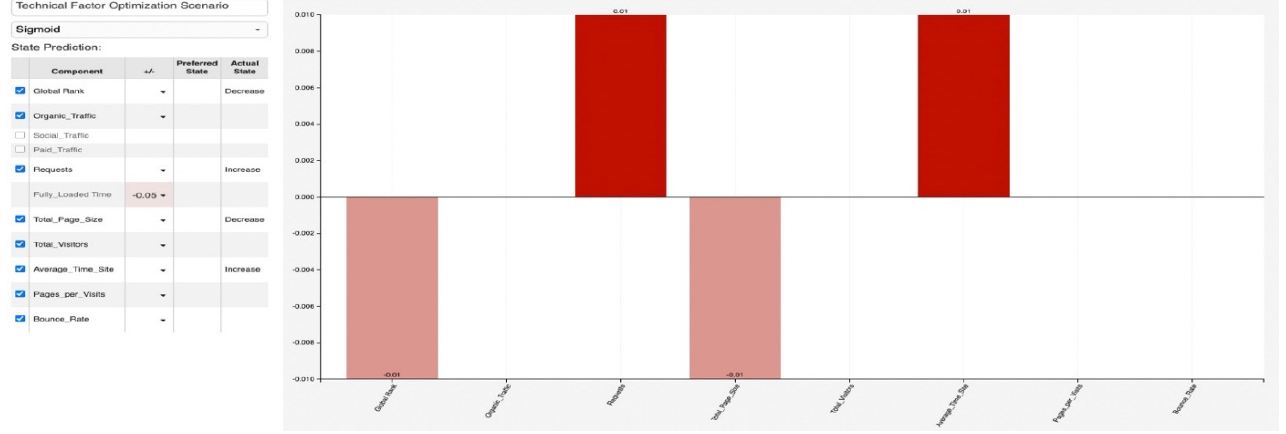
Figure 2. Technical Factors Optimization Scenario.